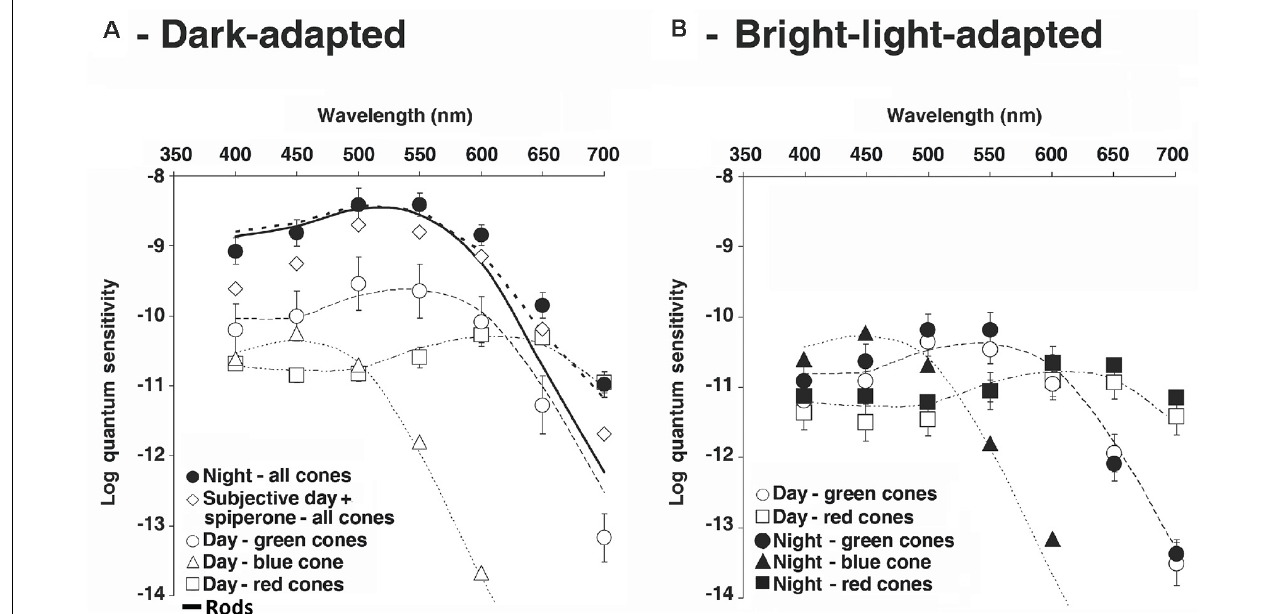
FIGURE 12 | Following maintained darkness goldfish cones exhibit red, green or blue spectral sensitivity in the day, but at night spectral sensitivity is similar to that of rods. (A,B) Cone spectral sensitivity resembled that of rod during the night in the dark and in the day following spiperone application, but not in the day in the dark or in the light. These results demonstrate that rod-cone gap junctions are function all open at night in the dark and in the day following blockade of D 4 Rs, functionally closed in the day. (A) Average spectral sensitivity of cones recorded under dark-adapted conditions during the day or subjective day fit one of three nomograms (thin dotted curves) corresponding to the three major known types of goldfish cone pigments: L, M, and S. Data were obtained from recorded red cones (open squares), green cones (open circles) and blue cone (open triangles). In contrast, the spectral sensitivity of all dark-adapted cones recorded at night peaked at ∼ 535 nm (filled circles). The cone spectral sensitivity at night under dark-adapted conditions closely fit a modified nomogram that combines goldfish rod and L-cone pigment nomograms (dotted thick curve; λ max = 537 ± 3 (SD) nm; r 2 = 0.91). Following application of spiperone (10 µ M; open diamonds), cone spectral sensitivity in the subjective day resembled that observed during the subjective night and data points fit well the modified nomogram ( λ max = 537 ± 3 nm; r 2 = 0.96). (B) Following bright light adaptation at night or during the subjective nightthree groups of cones with different spectral sensitivities were observed: red cones (filled squares), green cones (filled circles) and blue cone (filled triangles), whereas bright light adaptation during the day or subjective day did not affect the relative spectral sensitivity of the cones (red cones: open squares; green cones: open circles) but slightly decreased the absolute sensitivity. Nomograms as in (A). Data points represent average sensitivity ± SEM. Modified from Ribelayga et al.